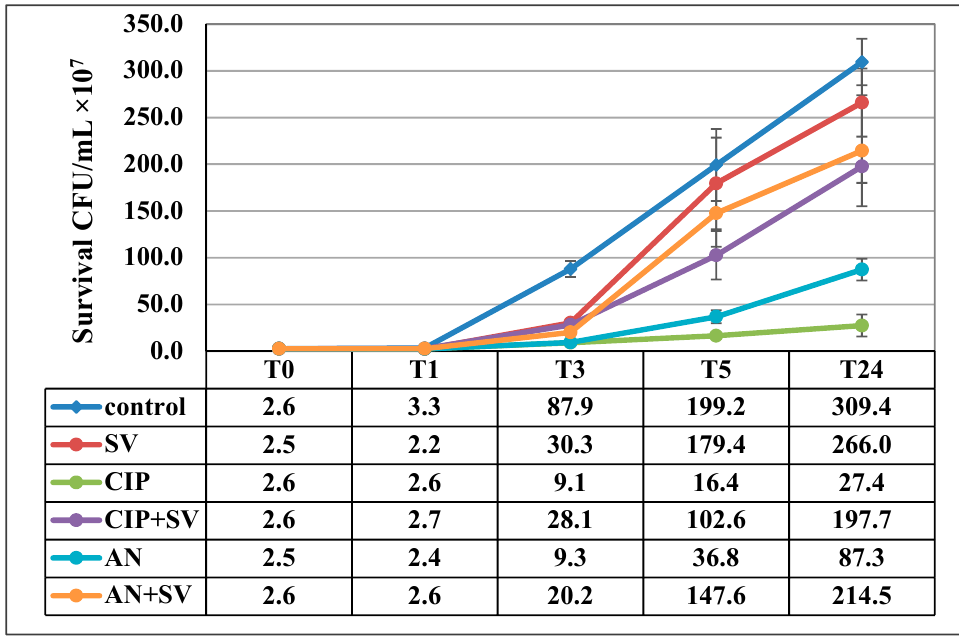
Figure 2. Survival of E. coli in the presence of S. virgaurea extract (SV), ciprofloxacin (CIP), amikacin (AN), S. virgaurea extract with ciprofloxacin (CIP+SV) and S. virgaurea extract with amikacin (AN+SV). Values represent the mean ± SD of three separate experiments.